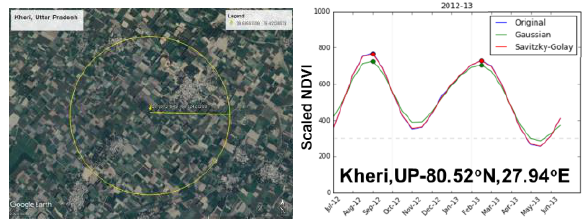
Figure 2: (Left) Zoomed in Google Image for 1-km pixel in Uttar Pradesh, found to have 2 cropping cycles in 2012-13. (Right) Effect of smoothening on time-series OCM NDVI